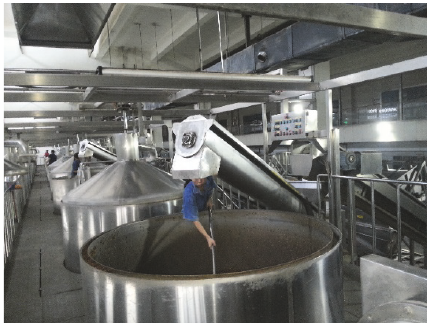
Figure 1: Nonrobot method for steamer-filling.